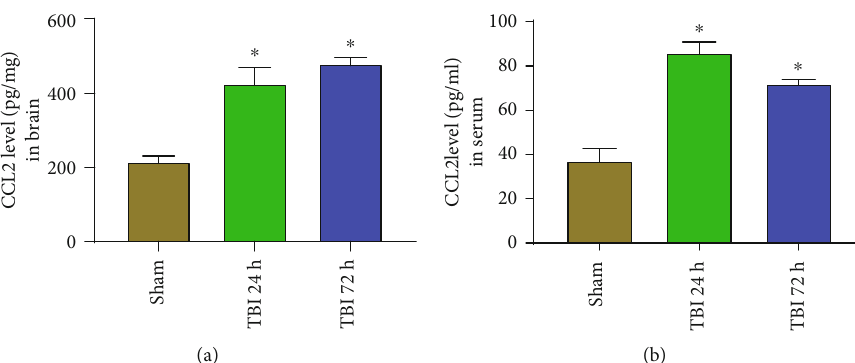
Figure 3: Increased level of CCL2 in the brain and serum of acute TBI mice. CCL2 level was quanti fi ed by ELISA in the brain tissue lysate and serum of 24 and 72h acute TBI mice and sham control mice without TBI ( n = 3 ). Results show signi fi cantly increased level of CCL2 in the (a) brains and (b) sera of both 24 h and 72h acute TBI as compared with sham control mice ( ∗ p < 0 : 05 , sham control vs. TBI).